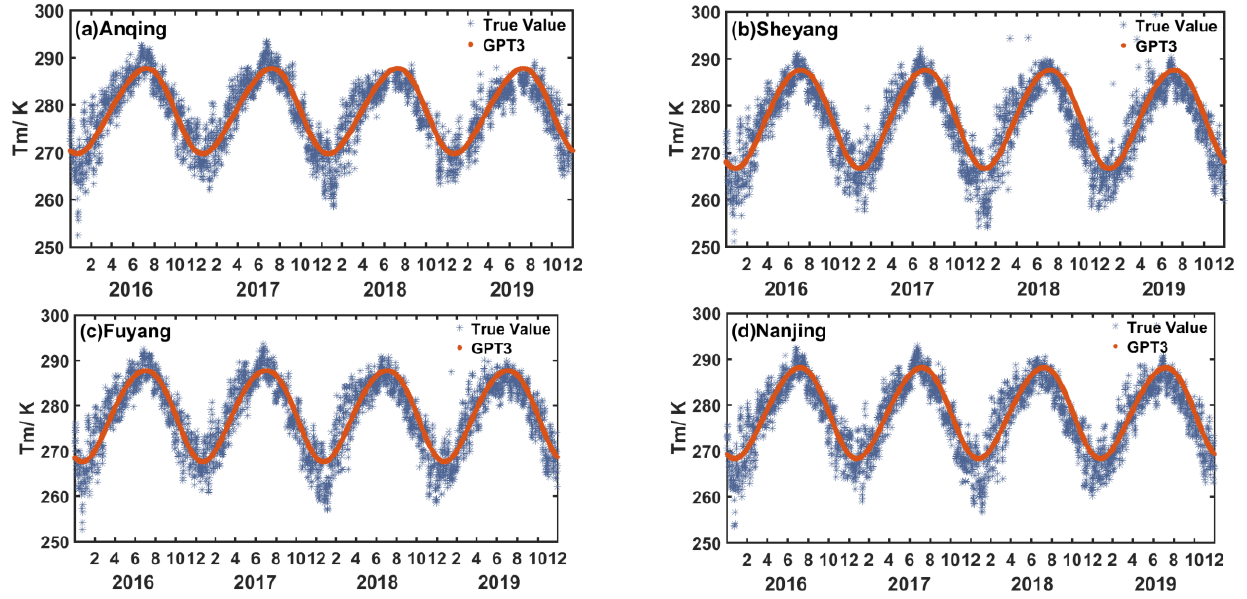
Table 3. Fourier coefficients of the GPT3- 𝑇 (cid:3040) bias in the Yangtze River Delta region during the 2016– 2018 period. Figure 5. Variations of the GPT3- 𝑇 (cid:3040) in Anqing ( a ), Sheyang ( b ), Fuyang ( c ), and Nanjing ( d ) during Figure 5. Variations of the GPT3- T m in Anqing ( a ), Sheyang ( b ), Fuyang ( c ), and Nanjing ( d ) during the 2016–2019 period. the 2016–2019 period.